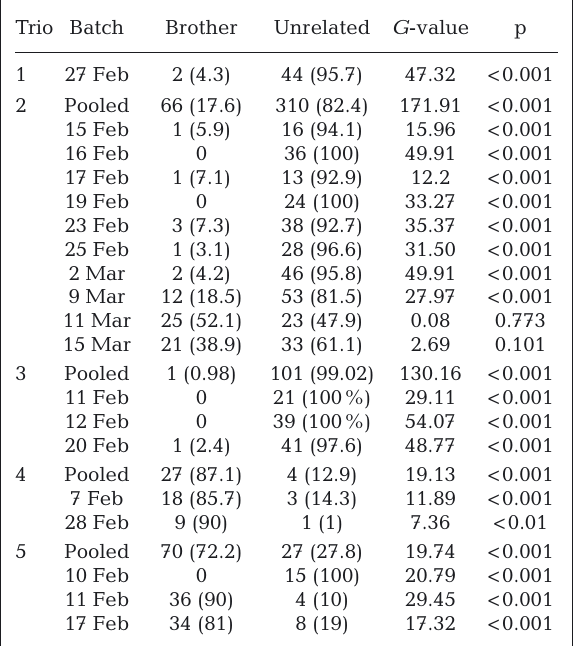
Table 2. Gadus morhua . Number of batches produced by each trio of Atlantic cod that spawned and the number of genotyped embryos sired by each male per batch, and pooled for the trio (percent of total eggs for batch/trio shown